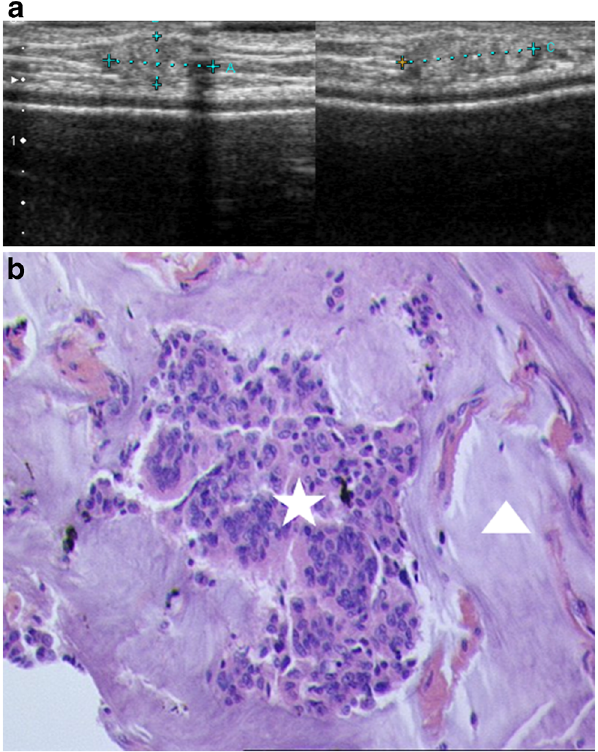
Fig. 15 Mucinous carcinoma. Patient with a local subcutaneous recurrence in the upper inner quadrant, 10 years after mastectomy with secondary prosthetic reconstruction. a Ultrasound: hyperechoic mass of the subcutaneous tissue, with slightly microlobular margins. b Histological examination of an ultrasound-guided microbiopsy (HES ×20): clumps of tumour cells ( asterisk ) surrounded by zones of mucin ( arrowhead )